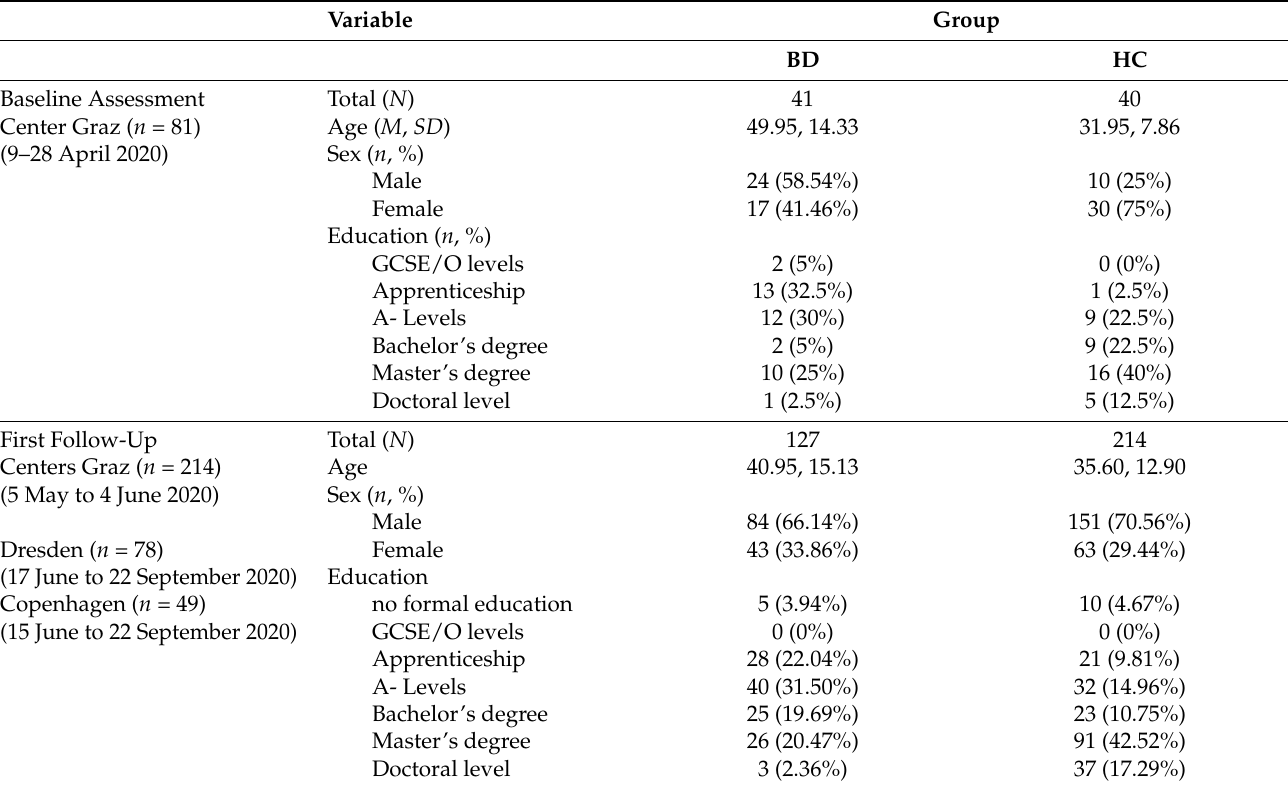
Table 2. Demographic data for each measurement